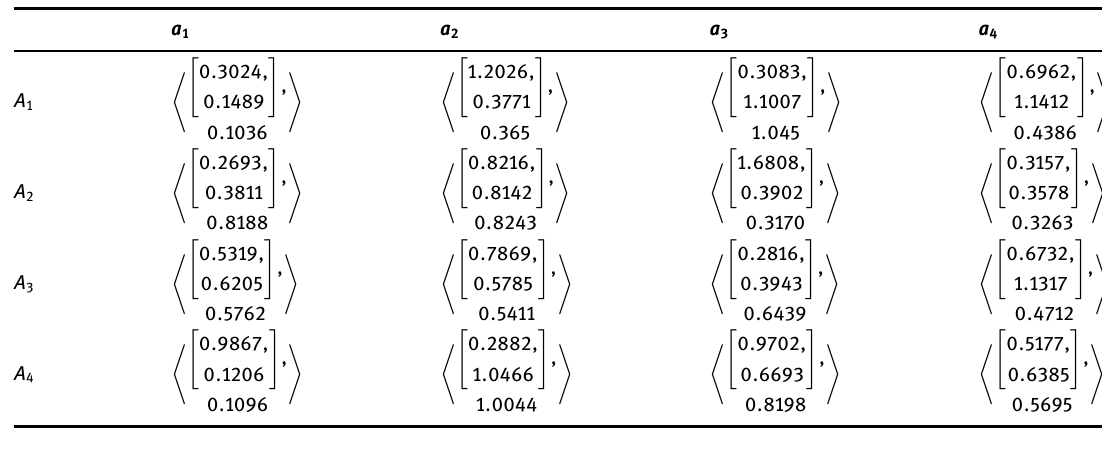
Table 7: Hamming Distance for Trapezoidal Cubic Fuzzy Number. a 1